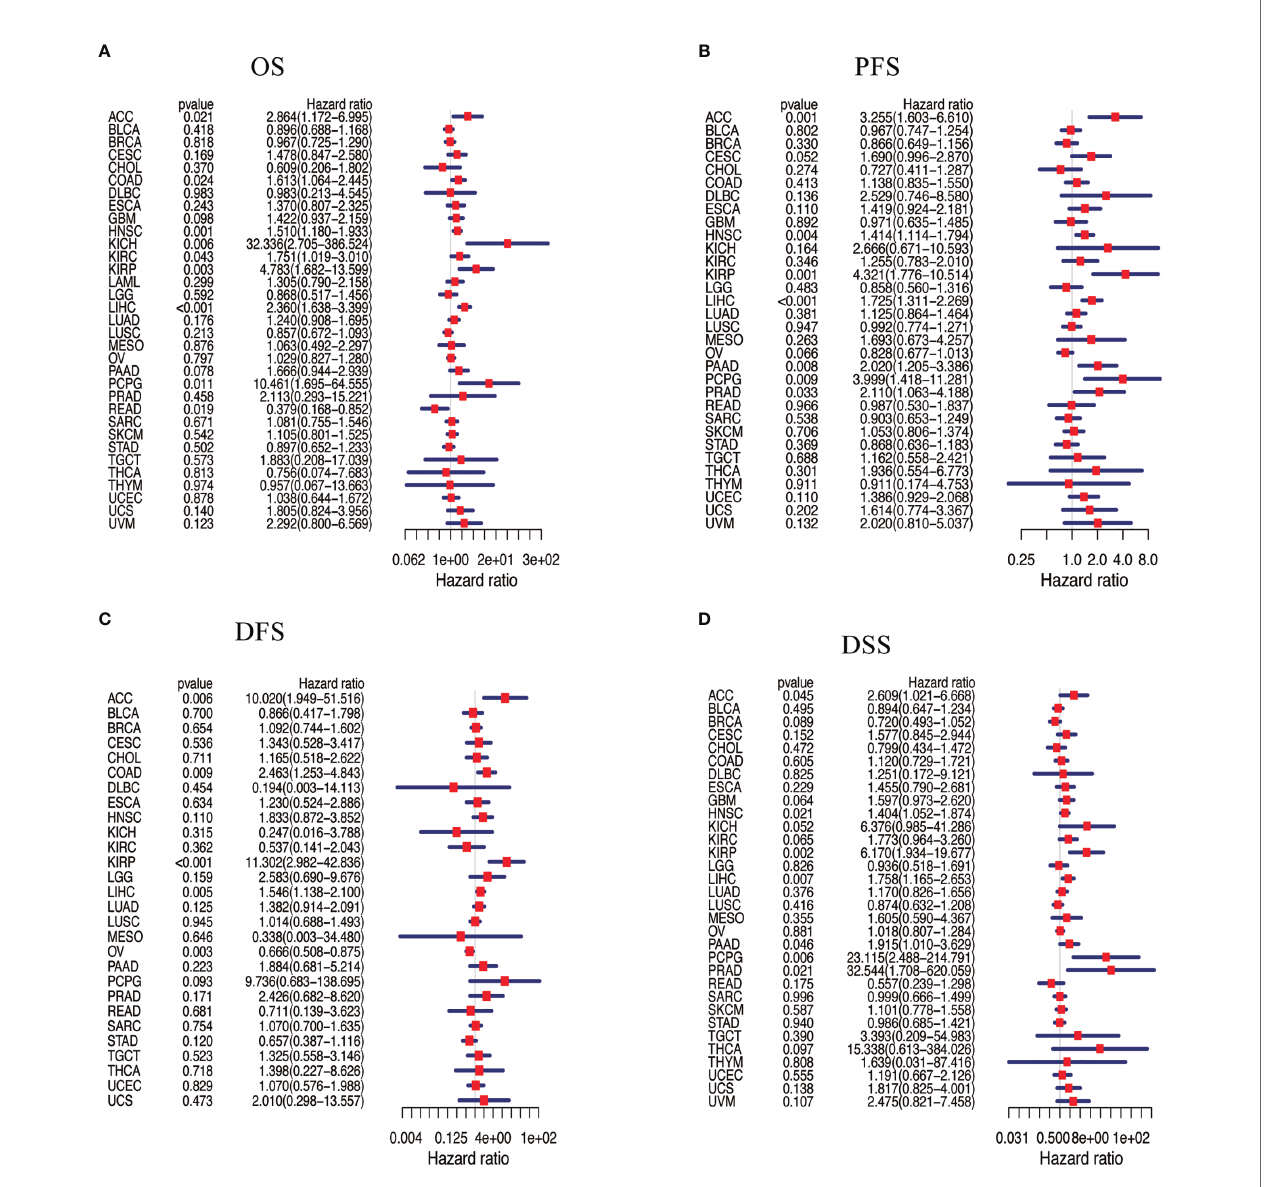
FIGURE 2 | Association between NAT10 expression levels and patient prognosis based on multiple tumors from TCGA database. (A) Relationship of NAT10 expression with OS. (B) Relationship of NAT10 expression with progression-free interval (PFI). (C) Relationship of NAT10 expression with disease-free interval (DFI). (D) Relationship of NAT10 expression with DSS. Cox regression analysis; P < 0.05 was considered signi fi